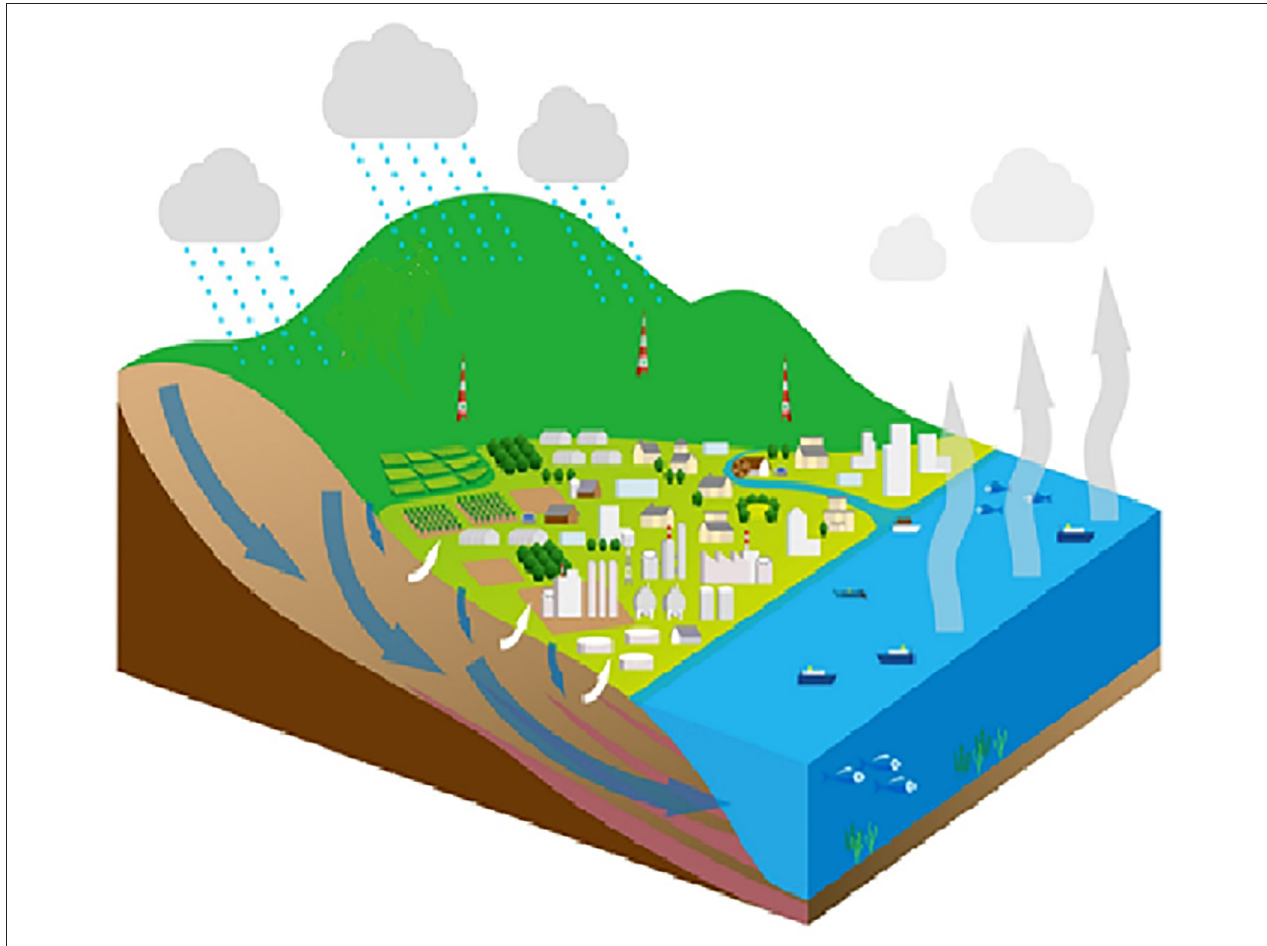
FIGURE 2 | Graphical presentation for targeted water-energy-food nexus between land and coastal areas in Beppu,